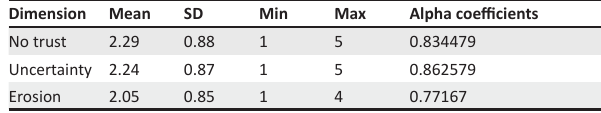
TABLE 7: Transitional psychological contracts.